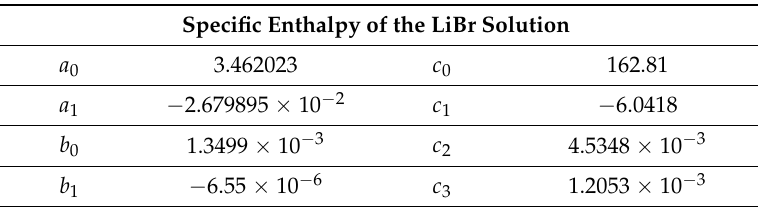
Table 2. Specific-enthalpy coefficients of the LiBr